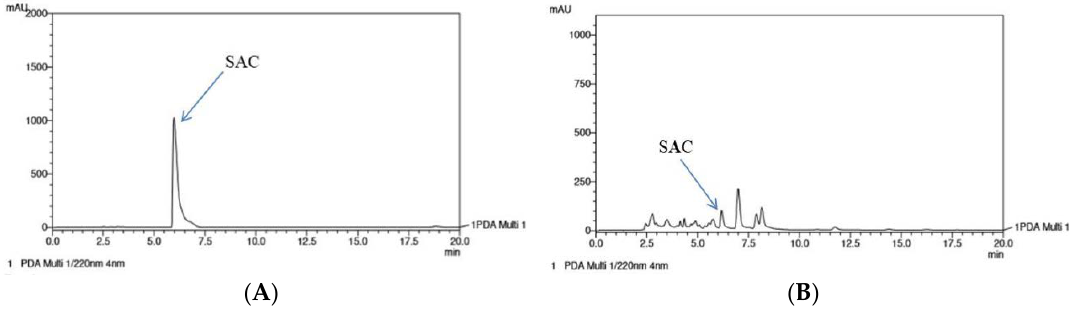
Figure 8. High-performance liquid chromatography (HPLC) chromatographs of the ( A ) standard and ( B ) water fraction of garlic extract. SAC: S-allylcysteine.